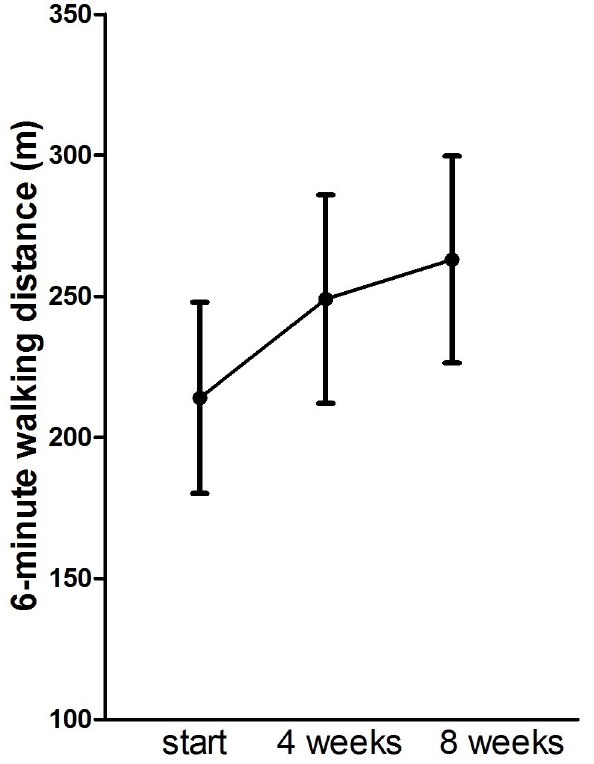
Fig 2. Changes in the primary outcome measure within the intervention